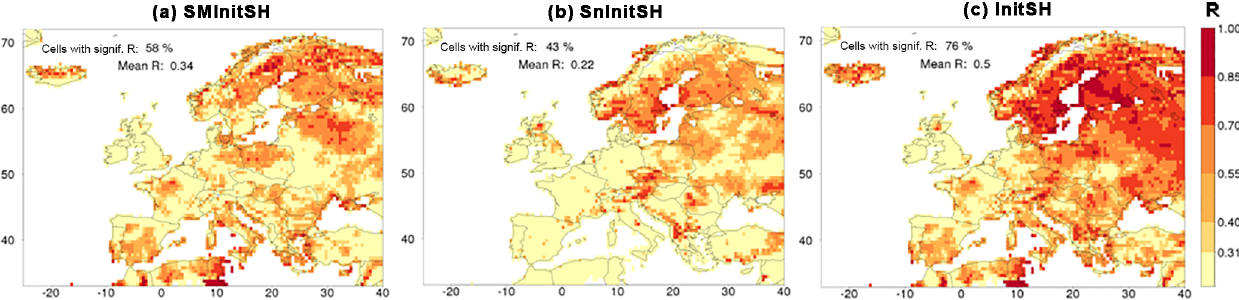
Figure 6. Example that compares the skill in run-off of three specific hindcasts (SMInitSHs – a , SnInitSHs – b and InitSHs – c ), for target month May as lead month 2. For more explanation, see Fig. 1a. White, terrestrial cells correspond to cells where observations or hindcasts consist for more than one-third of zeros or one-sixth of ties.